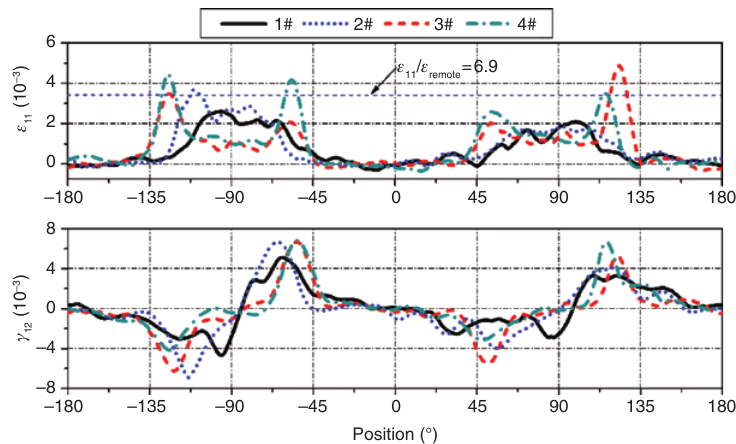
Figure 5: Strain distribution along the edge of the hole for different specimens.